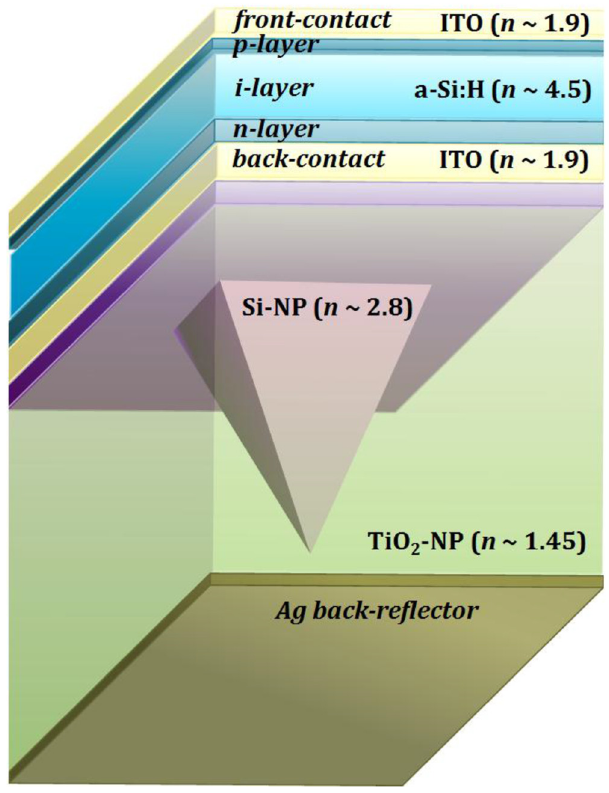
Fig. 1. Schematic illustration of BLiS back-re fl ector for n-i-p Si thin fi lm solar cells. The TiO 2 -NP layer over the planar silver back-re fl ector has inverted pyramidal shaped microcavities, which is further covered by a fl at-topped Si-NP